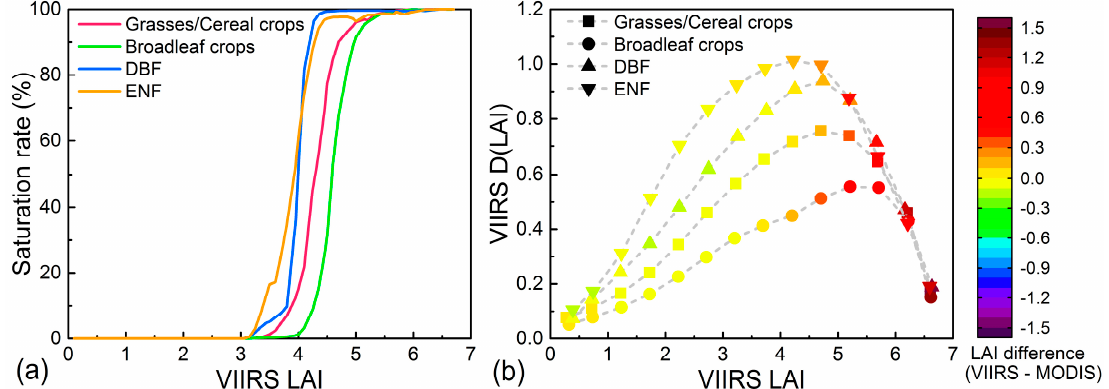
Figure 9. ( a ) The variation of saturation rate with VIIRS LAI retrievals; ( b ) The relationship among VIIRS LAI (x-axis), DLAI (y-axis) and the difference (colorbar) between VIIRS and MODIS LAI retrievals using all composition periods from 2012 to 2016. “DBF” and “ENF” represent “deciduous broadleaf forest” and “evergreen needleleaf forest”, respectively.